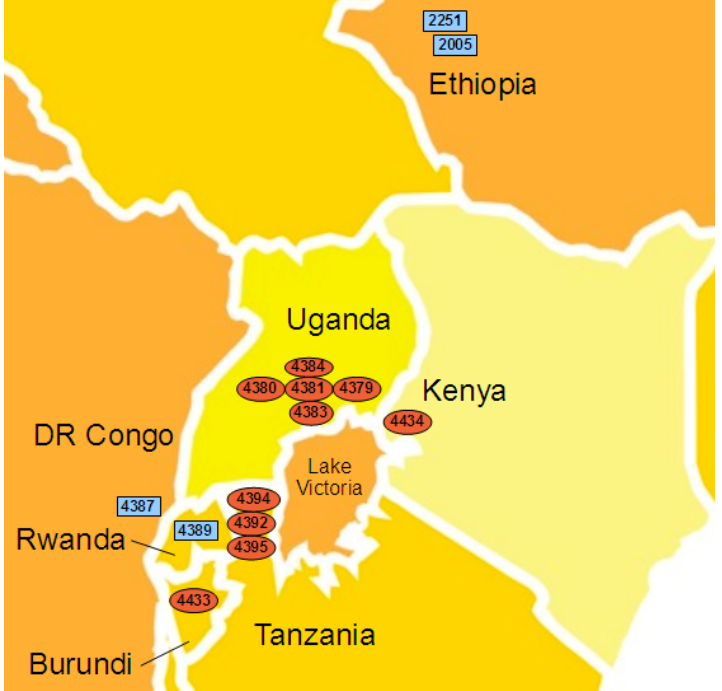
Figure 3. Geographical distribution of the two major sub-lineages of Xcm . The approximate geographical locations are indicated for each of the fully sequenced Xcm isolates from Ethiopia (NCPPB2005 and NCPPB2251), Uganda (NCPPB4379, NCPPB4380, NCPPB4381, NCPPB4383 and NCPPB4384), Kenya (NCPPB4434), Tanzania (NCPPB4392, NCPPB4394 and NCPPB4395), DR Congo (NCPPB4387), Rwanda (NCPPB4389) and Burundi (NCPPB4433). Blue rectangles indicate locations of isolates belonging to sub-lineage I and red ovals indicate those of sub-lineage